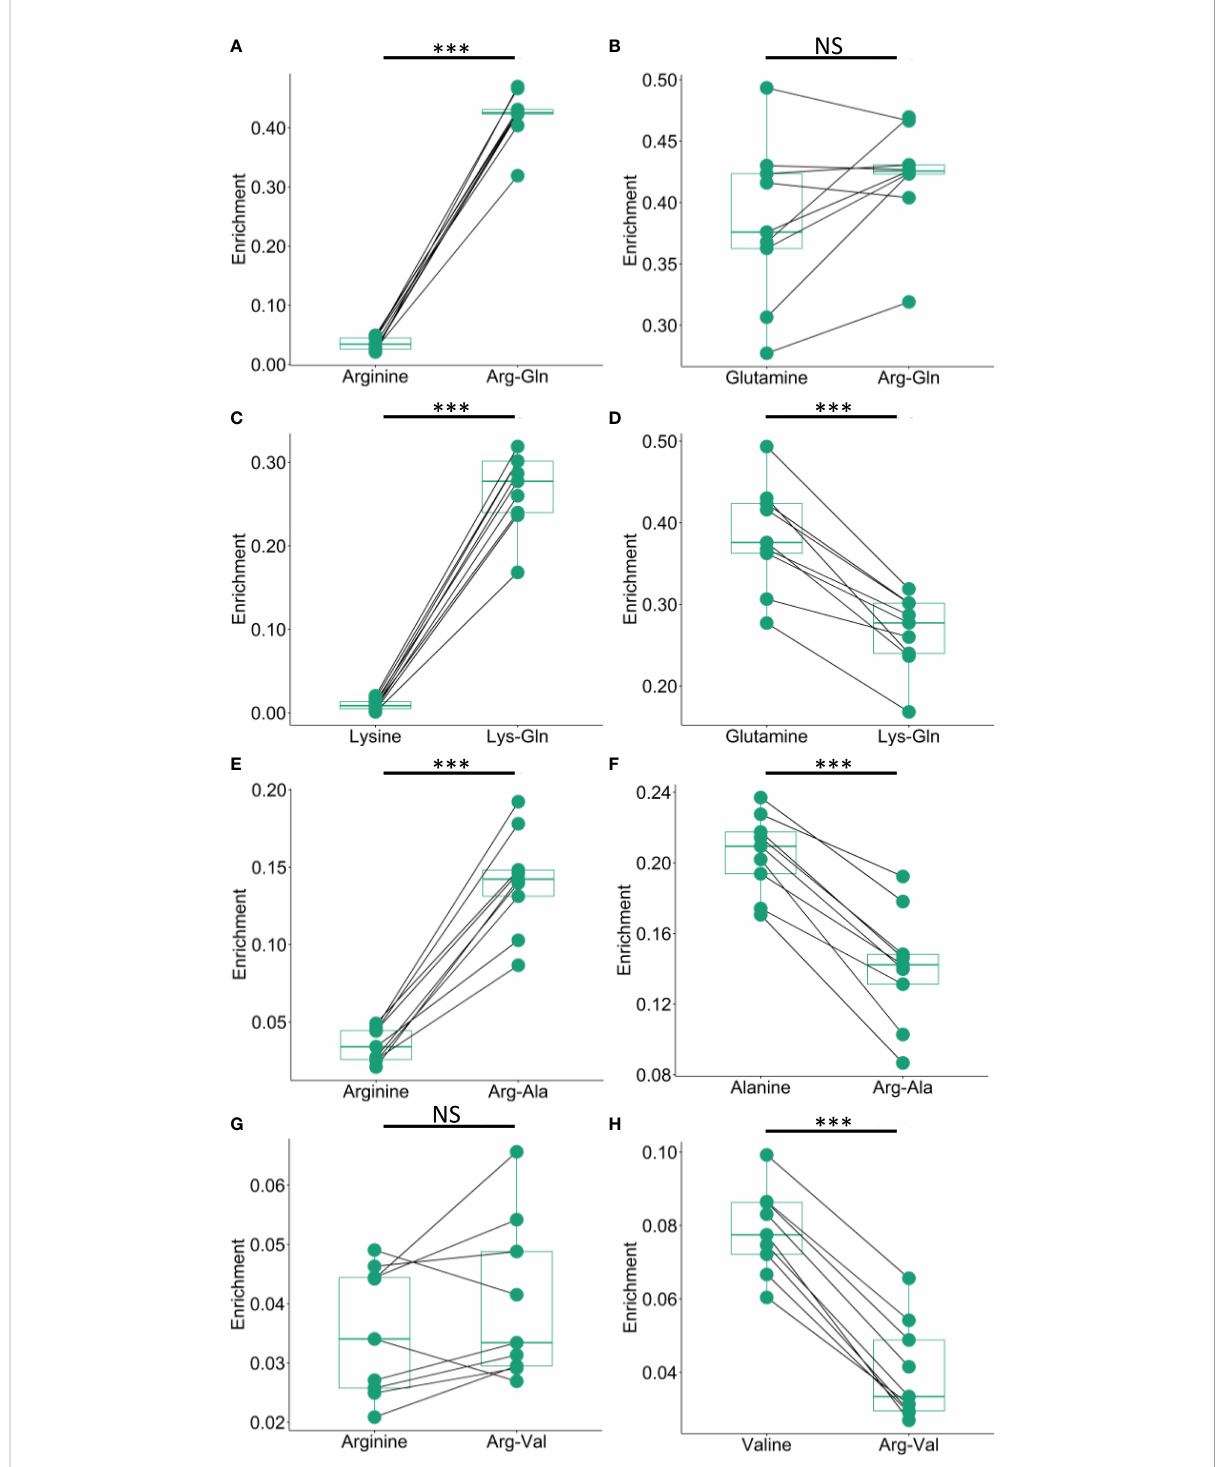
FIGURE 4 Comparison of dipeptide and constitutive amino acid enrichment in M. capitata . (A, B) Comparison of the enrichment of arginine and glutamine to the enrichment of the dipeptide arginine-glutamine. (C, D) Comparison of the enrichment lysine and glutamine to the enrichment of the dipeptide lysine-glutamine. (E, F) Comparison of the enrichment of arginine and alanine to the enrichment of the dipeptide arginine-alanine. (G, H) Comparison of the enrichment of arginine and valine to the enrichment of the dipeptide arginine-valine. Asterisks denote signi fi cance at *P <0.05, **P <0.01, ***P <0.001, and NS denotes result is not signi fi